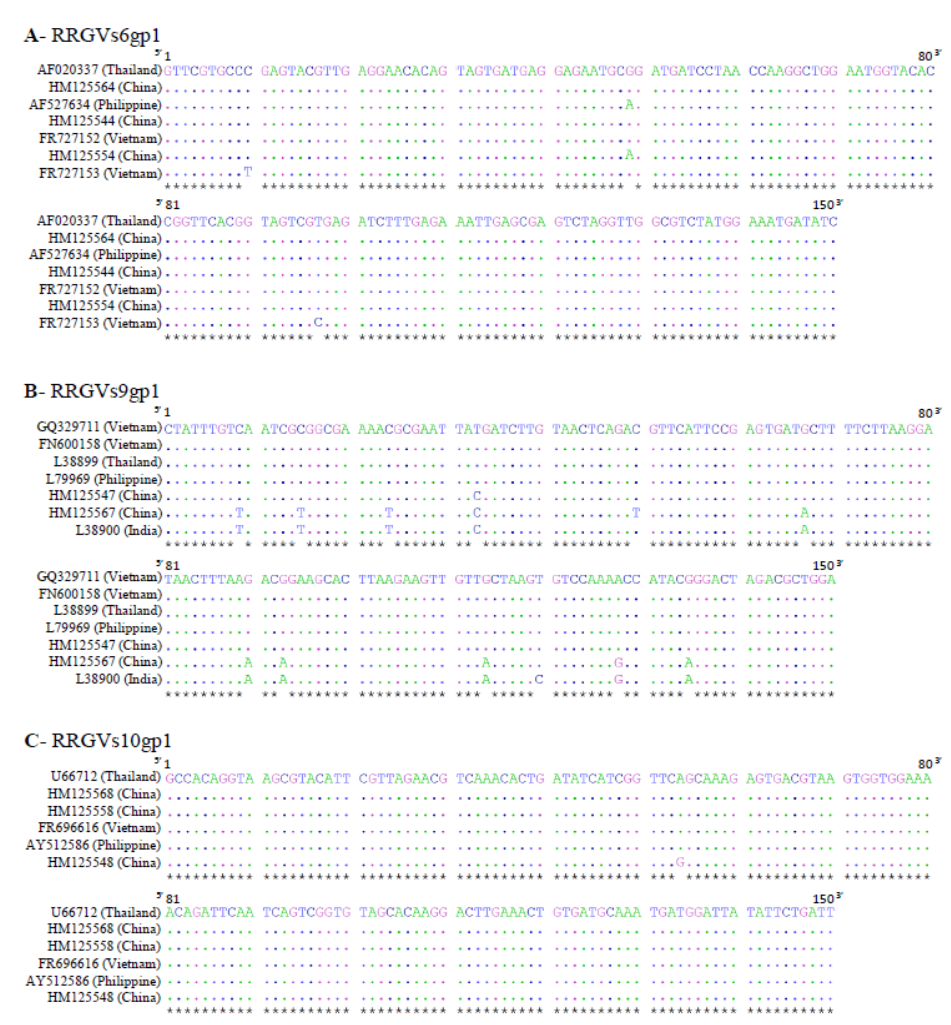
Figure 4. Alignment of selected siRNA regions from RRSVs6gp1 ( A ), RRSVs9gp1 ( B ), and RRSVs10gp1 ( C ) with RRSV sequences from the GenBank resource. The accession number and origin of each sequence are indicated. Nucleotide identity is represented by a dot. Stars at the bottom indicate the nucleotide identity among all the selected sequences. Numbers above sequences indicate nucleotide positions and orientations.